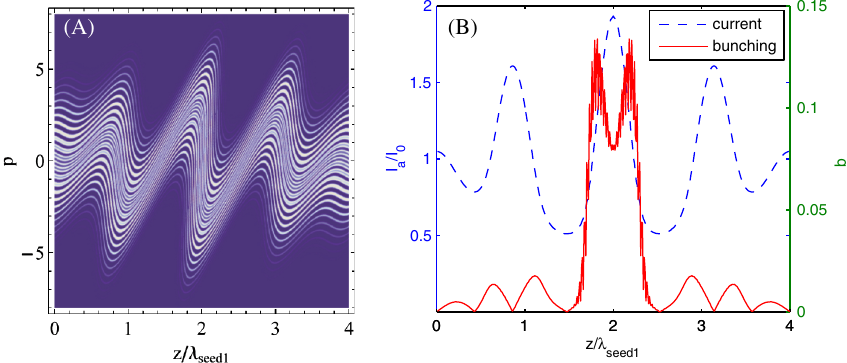
FIG. 3. Phase space (a) and corresponding local current factor and local bunching factor distributions (b) at the exit of